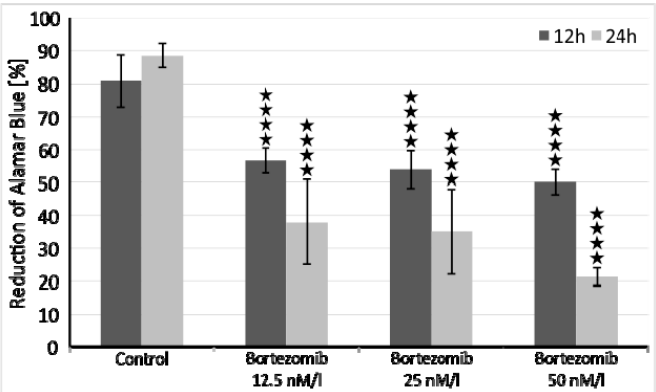
Figure 1. Cell viability assays with Alamar Blue. Data are presented as a percentage of Alamar Blue reduction, observed in 12 or 24-h period. **** p < 0.0001 compared with the control cells.